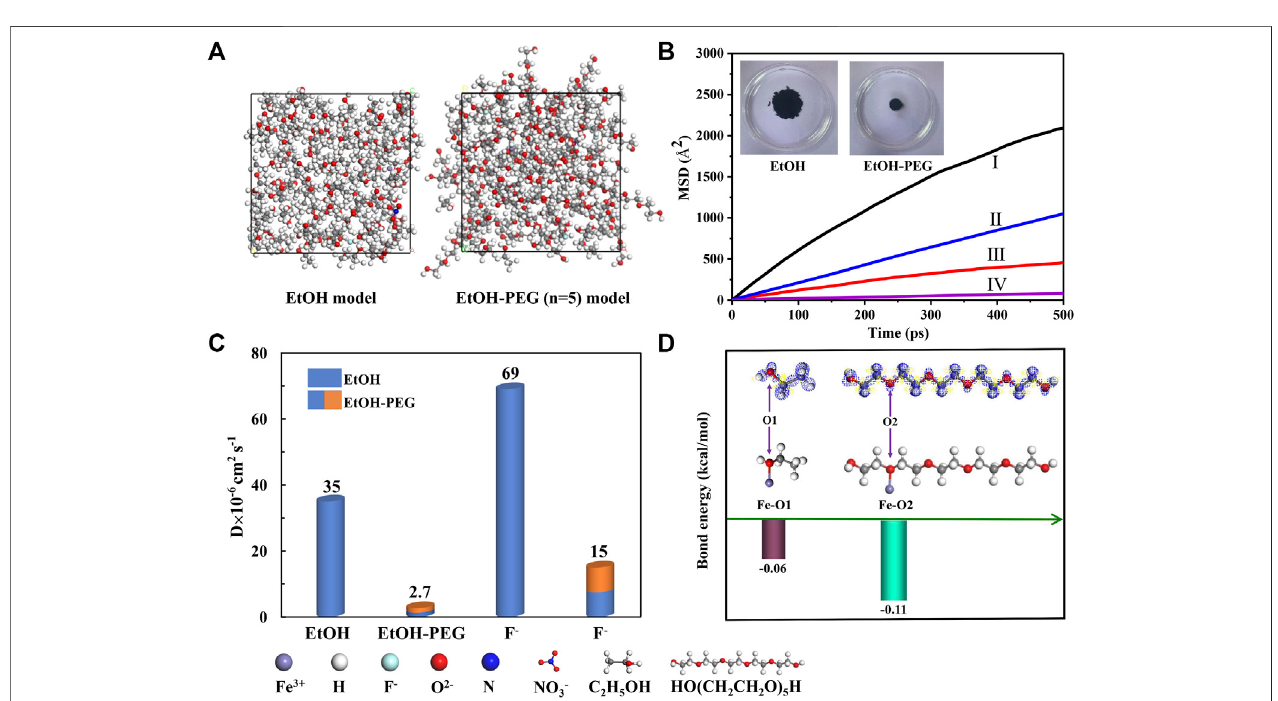
FIGURE 4 | (A) The calculated models for EtOH (40 ml) and EtOH (20 ml)-PEG (20 ml) ( n (cid:2) 5). (B) The MSD analysis of molecules and F − in the EtOH solution and EtOH-PEGmixedsolution(IandIIIrepresentthemeansquaredisplacement(MSD)ofF − intheEtOHsolutionandEtOH-PEGmixedsolution,IIandIVrepresentthemean square displacement (MSD) of molecules in the EtOH solution and EtOH-PEG mixed solution); inset: the diffusion of 100 μ L ink in the EtOH (40 ml) solution and EtOH (20 ml)-PEG (20 ml) mixed solution after 10 s. (C) The corresponding diffusion coef fi cient of molecules and F − in the EtOH solution and EtOH-PEG mixed solution. (D) The bondenergybetweenFe and Oatoms indifferentposition(inset: theupper part ofthepicture istheelectron density differencemap, inwhich theblue areaisthe position where the electron density has been enriched relative to the debris, and the yellow area is the position where the density has been exhausted).